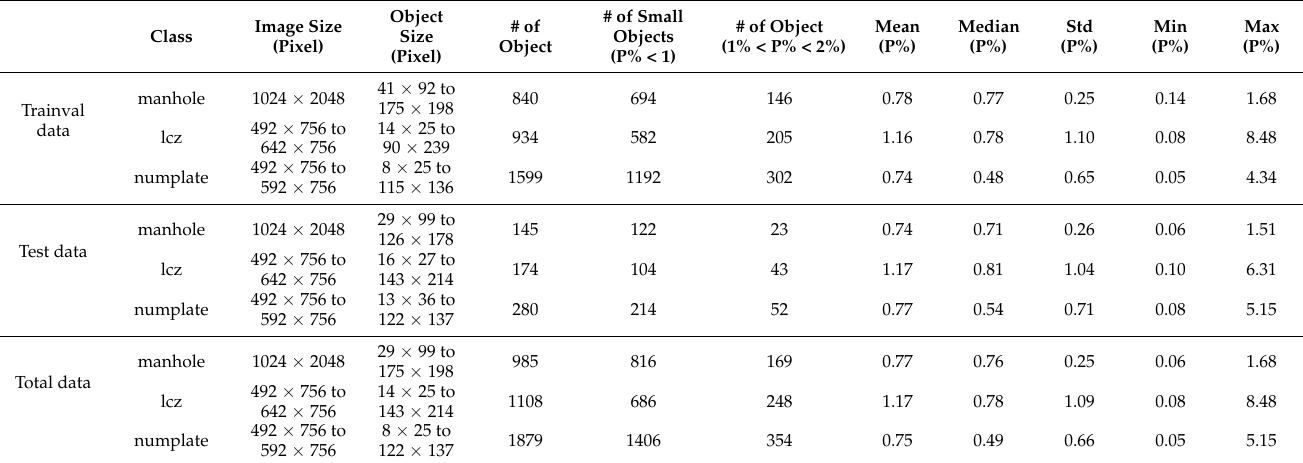
Figure 5. Histogram showing percentage of object size in image for UED dataset.